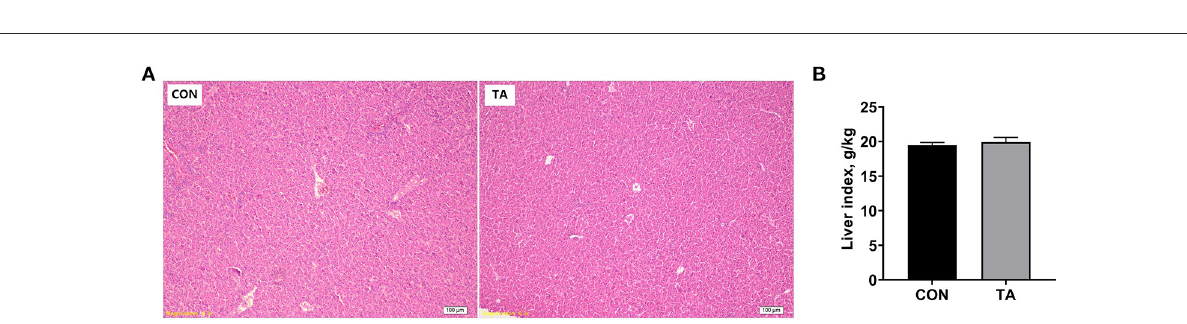
FIGURE3 Effects of dietary supplemented with microencapsulated TA from Galla Chinensis on liver morphological sections and liver index of broiler chickens. (A) Liver morphological sections, (B) Liver index (g/kg) = liver weight (g)/body weight (kg). CON, broiler chickens fed a basal diet; TA, broiler chickens fed a basal diet supplemented with 300 mg/kg microencapsulated TA from Galla Chinens is. Values are mean ± standard error ( n =